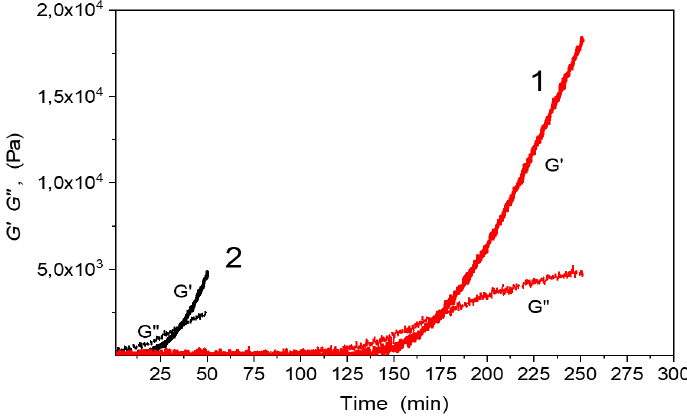
Figure 8. Evolution of dynamic moduli G‘(t), G“(t) during formation of the F4D2000–PPO3BMI network from monomers (curves 1) and from the broken-up structure (curves 2); T = 50 °C.